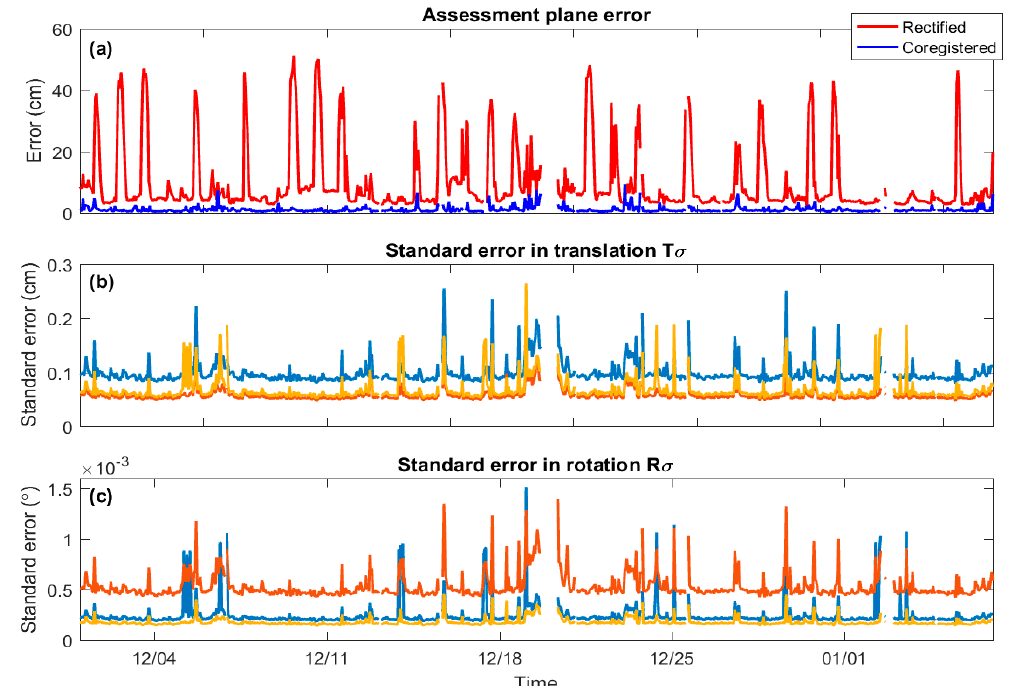
Figure 5. ( a ) The magnitude of the offset in the three error assessment planes from the rectified scans (red) and the co-registered scans (blue), along with ( b ) the residual standard errors in translation ( x (blue), y (red), and z (yellow)) and ( c ) the residual standard errors in rotation (roll (blue), pitch (red), and yaw (yellow)) determined from the least-squares fit for all scans that were successfully co-registered from 1 December 2016 through 7 January 2017.